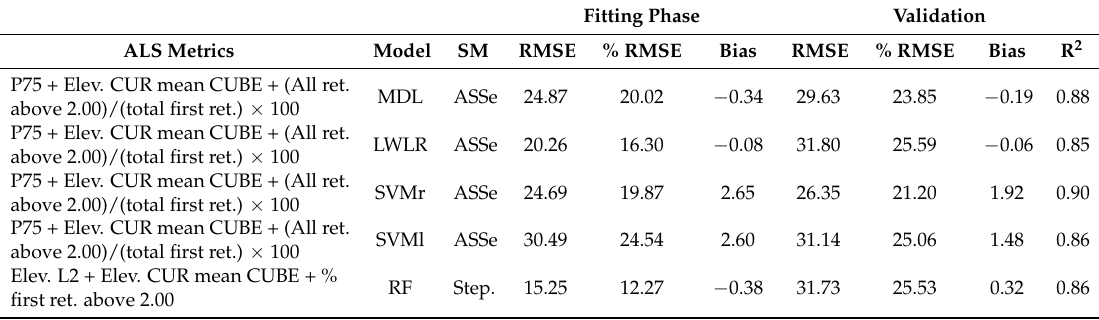
Table A13. Summary of the V models using 2016 ALS data. Validation results in terms of RMSE (m 3 ha − 1 ), %RMSE, and bias (m 3 ha − 1 ) and R 2 . SM refers to selection method; Step. stands for Stepwise both and forward; SVMr. refers to support vector machine with radial kernel; SVM l. refers to support vector machine with linear kernel; ret. refers to